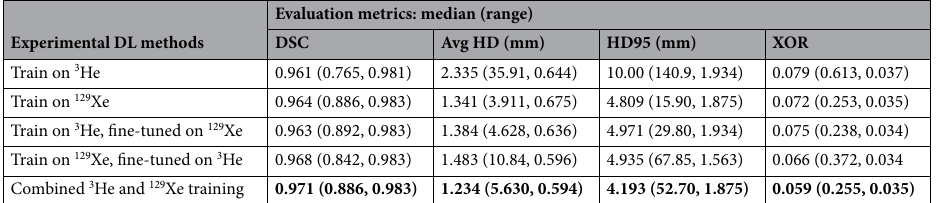
Table 2. Comparison of segmentation performance for the five DL training methods for all scans in the testing set. Medians (ranges) are given; the best result for each metric is in bold.